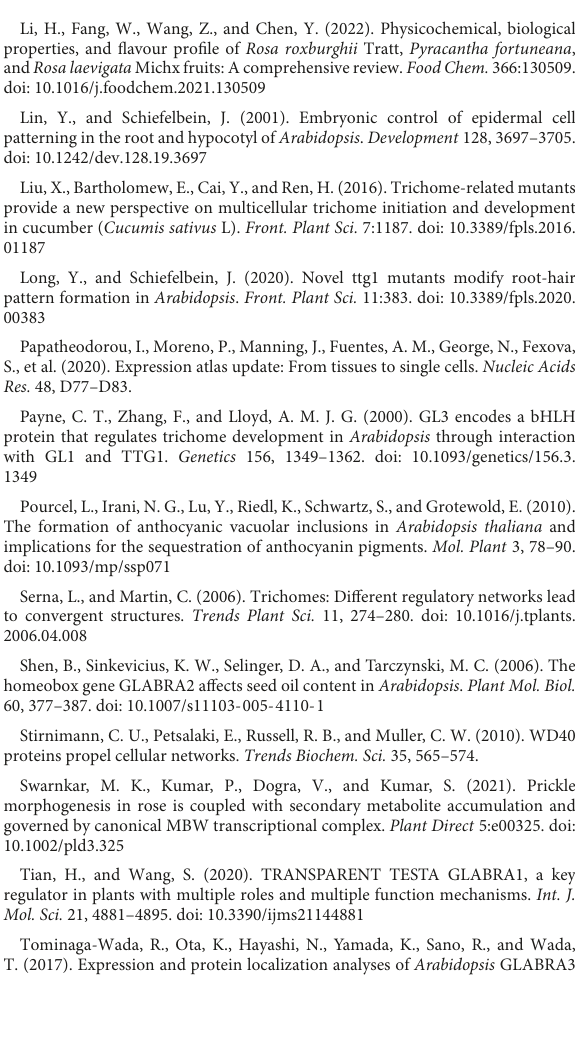
SUPPLEMENTARYFIGURE1 Control experiment of yeast two-hybrid assay. The combinations of pGADT7 and pGBKT7-Lam, as well as pGADT7 and pGBKT7-53, were used as negative and positive control, respectively. Meanwhile, the combinations of empty vector (pGADT7 or pGBKT7) with all the tested proteins were also performed, and no self-activation was